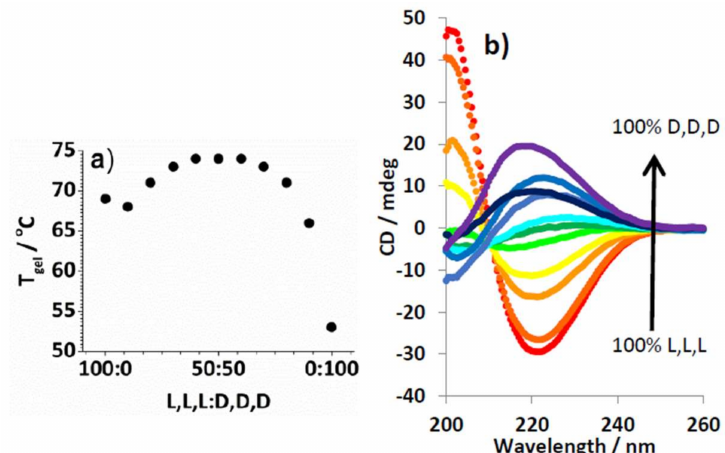
Figure 7. ( a ) Effect of mixing L,L,L and D,D,D (total combined concentration, 10 mM) on the T gel value in the presence of C8R (10 mM); ( b ) CD spectra of mixtures of L,L,L and D,D,D (total concentration = 0.625 mM), changing in 10% concentration increments from 100% LLL (red) to 100% DDD (purple) in the presence of C8R (0.625